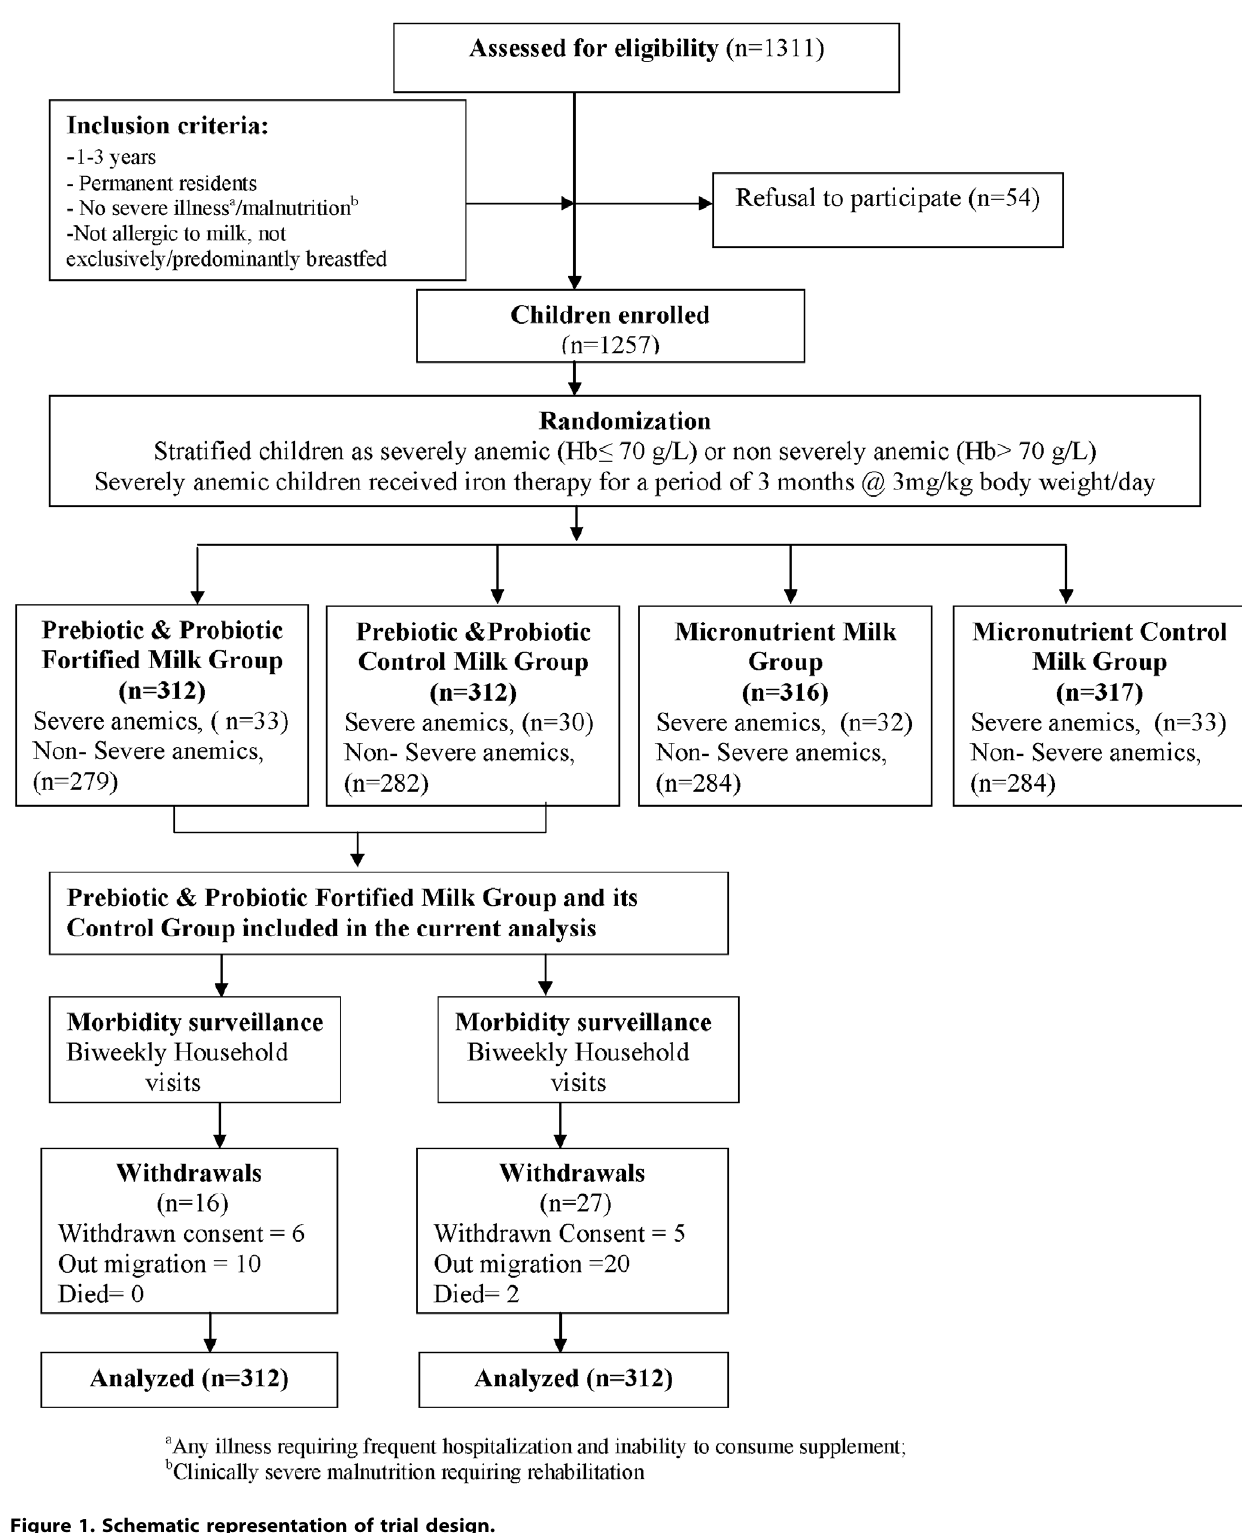
ful; for children aged 12 to 24 months rate of diarrhea was [1% lower (95% CI: 2 11% to 11%), p = 0.91] and children aged . 24 months it was [10% lower (95% CI: 2% to 17%), p = 0.02]; p- value for test of difference= 0.03. The incidence of dysentery was